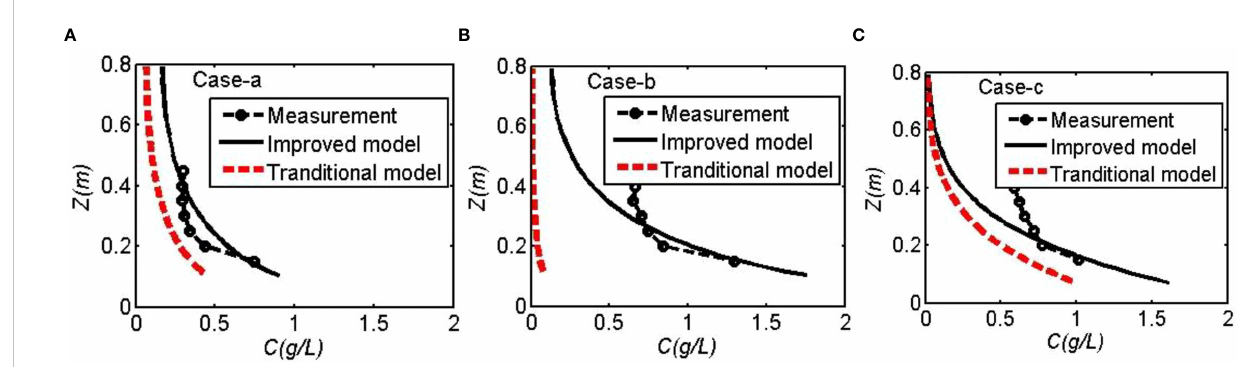
FIGURE 6 Measured and simulated sediment concentrations in Test 3: (A) Case-a, (B) Case-b, (C) Case-c.